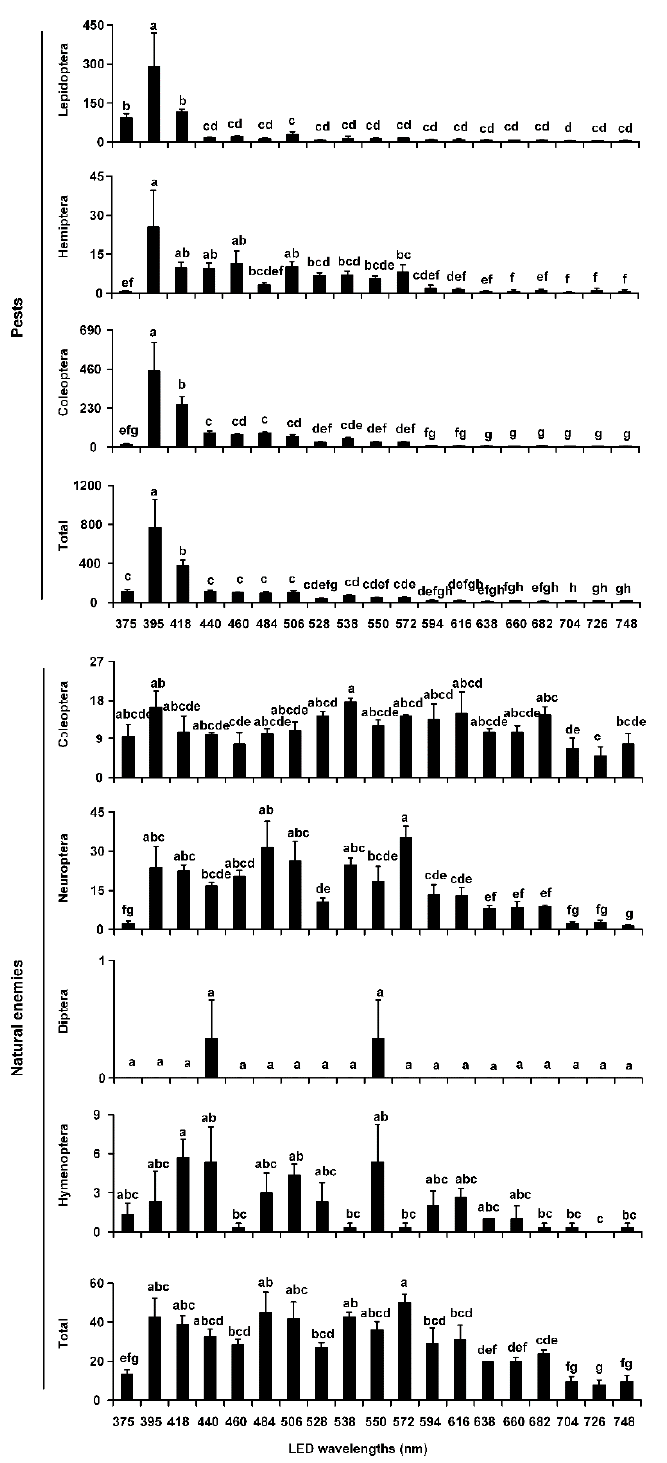
Figure 2. Average abundances of pests and natural enemies in different taxonomic groups trapped by LED-equipped traps with 19 single wavelengths in 2014. The bar charts show the average number of pests or natural enemies caught per trap, as recorded during trials in cotton fields in Xinxiang County (Xinxiang, China). Individual bars represent the mean (±SE) trap capture, with accompanying letters denoting statistically significant differences among the LED wavelengths in a given order or total pests or natural enemies (ANOVA, p < 0.05).